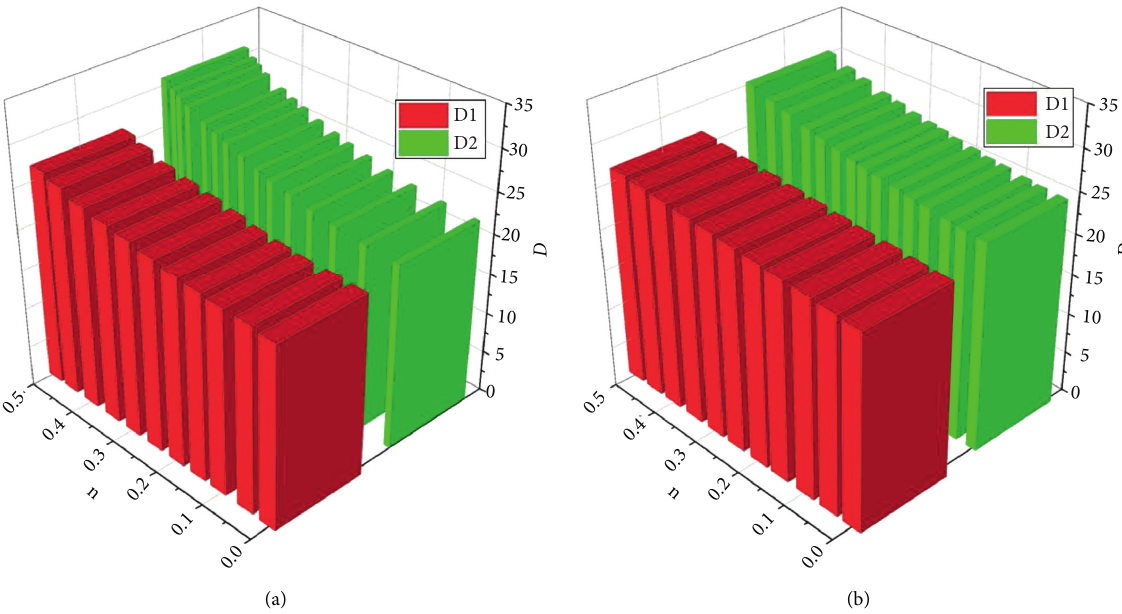
Figure 5: Relationship between cycle demand and advertising sensitivity. (a) Short-term advertising sensitivity and (b) long-term ad- vertising